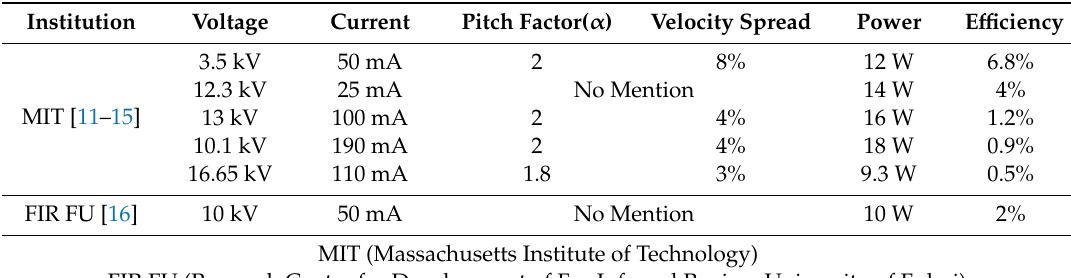
Table 1. Performance parameters of latest low-voltage gyrotron.